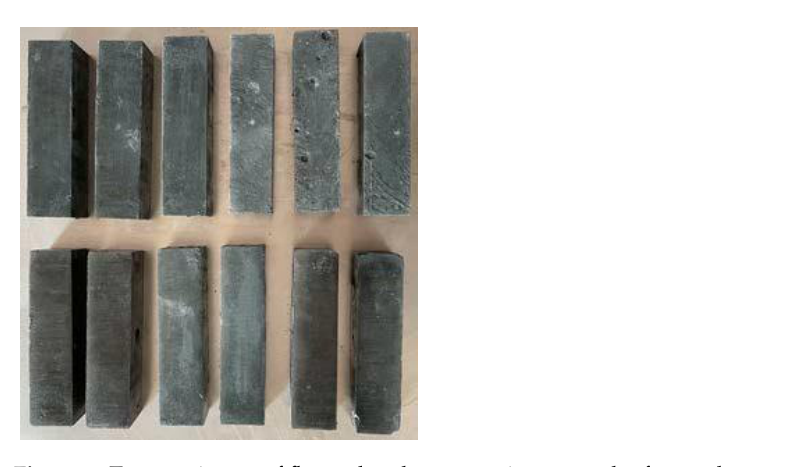
Figure 3. Test specimens of flexural and compressive strength of geopolymer.